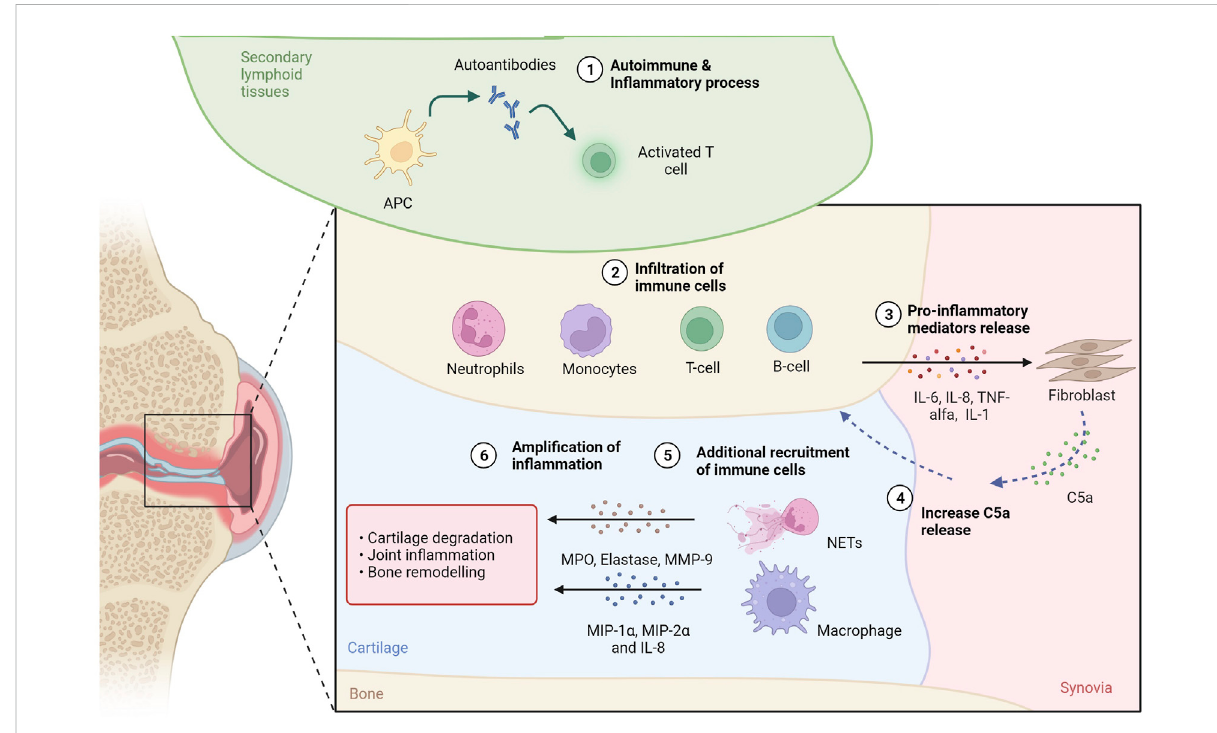
FIGURE 2 C5a in rheumatoid arthritis. In secondary tissues of RA patients, production of autoantibodies 1) activates in fl ammation and attracts immune cells 2), such as T and B lymphocytes, neutrophils and monocytes, to the in fl ammation site. The release of proin fl ammatory molecules 3) drives the proliferation ofsynovial tissue fi broblasts,which cancontributeto theincreaseofC5alevelsinthesynovial fl uid(SF) 4).C5acontributes toadditional immune cell recruitment 5) and activation: neutro fi ls can undergo NETosis releasing proteaseses (i.e., MPO, elastase, MMP-9), while macrophages can release in fl ammatory proteins (i.e., MIP-1 α , MIP-2 α and IL-8). The release of proteases and proin fl ammatory proteins supports cartilage degradation, joint in fl ammation and bone remodeling, amply fi ng the in fl ammatory state 6). Created with